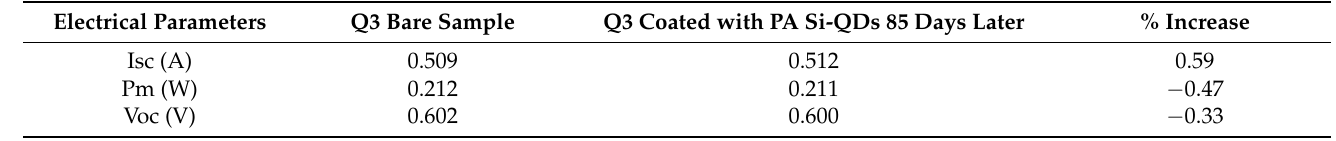
Table 8. Electrical parameters of Q3 sample before coating (bare cell) and after coating with PA Si-QDs 85 days